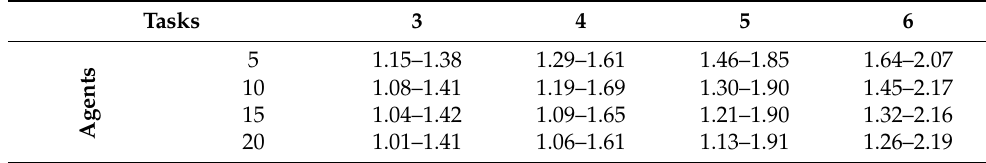
Table 9. Range of Reliability Improvement Factor (Scenario 3).